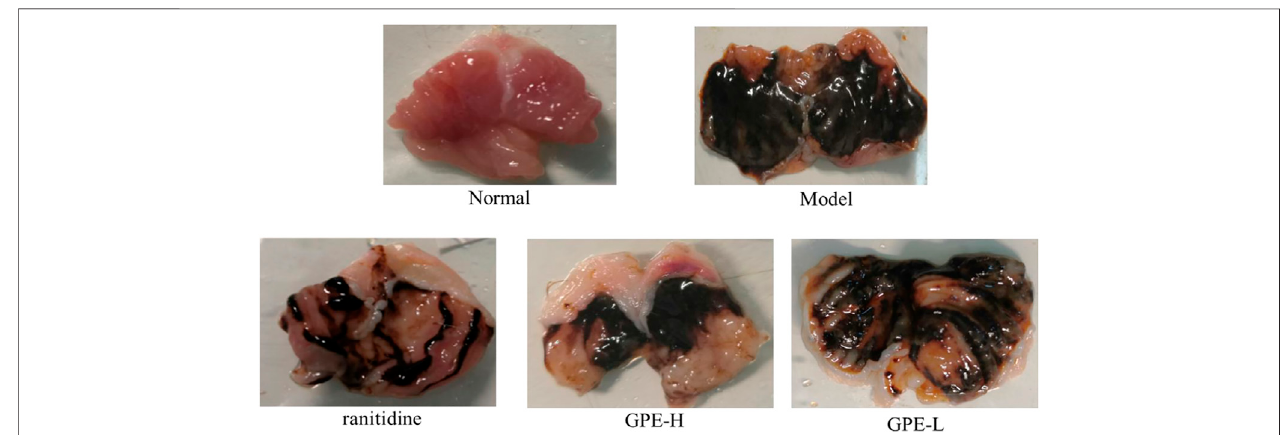
FIGURE 3 | Images of stomach specimens from mice of each group. ranitidine, mice treated with 50 mg/kg ranitidine; GPE-H, mice treated with 300 mg/kg GPE; GPE-L, mice treated with 150 mg/kg GPE.